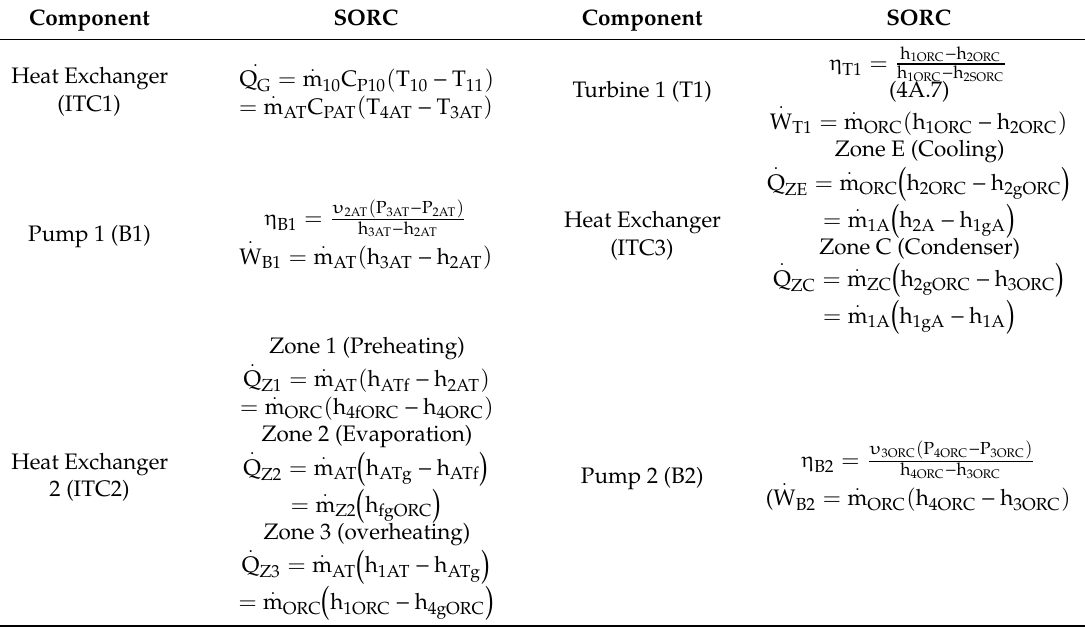
Table 3. Energy balances for the components of simple organic Rankine cycle (SORC) configuration. Component SORC Component